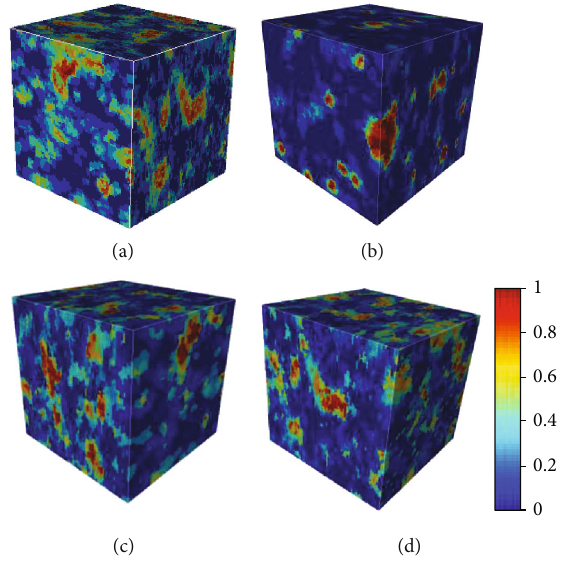
Figure 17: Averages of 10 reconstructed sandstone images using (a) SNESIM; (b) DTL; (c) FILTERSIM; (d)